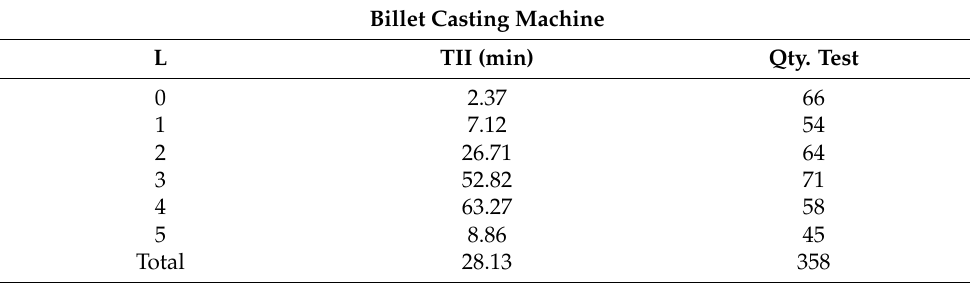
Table 5. TII in billet machine, grouped according to active